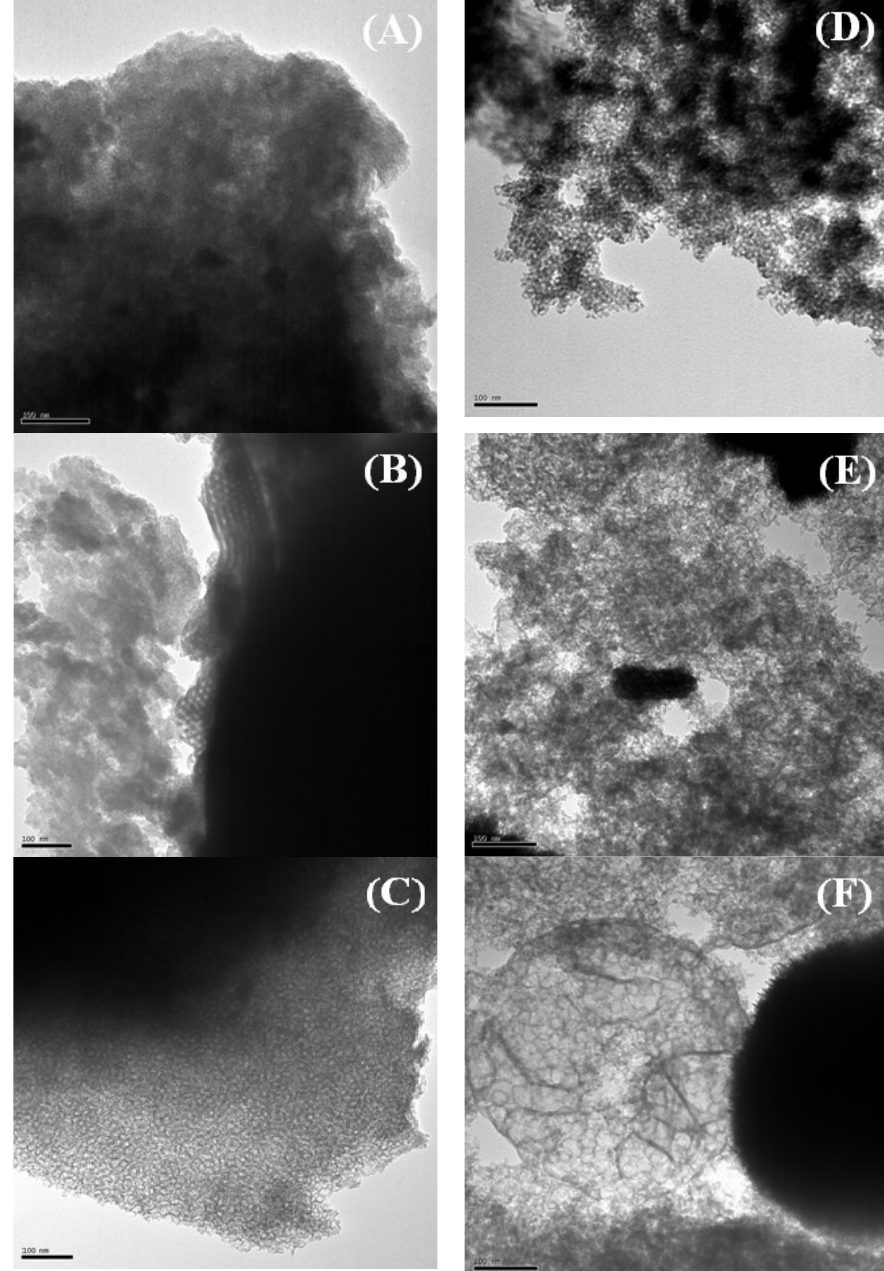
Figure 2. Transmission electronic microscopy (TEM) micrographs of RT ( A ), RT-TMB ( B ), RT-F-TMB ( C ), HT ( D ), HT-TMB ( E ), HT-F-TMB ( F ). Scale Bars: 100 nm .